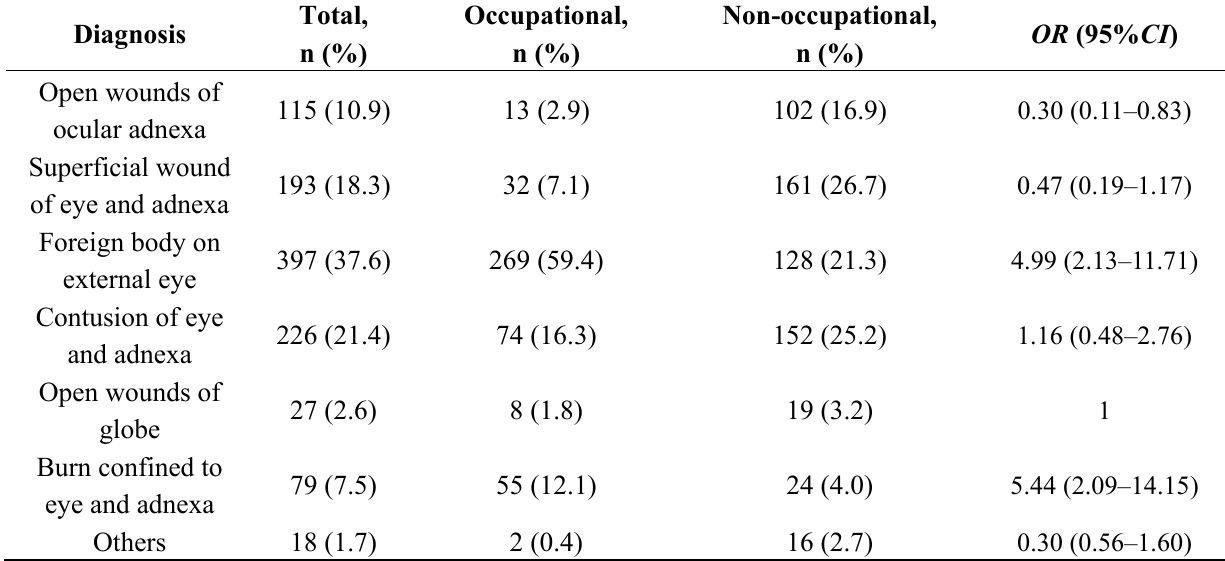
Table 3. Diagnosis of occupational and non-occupational eye